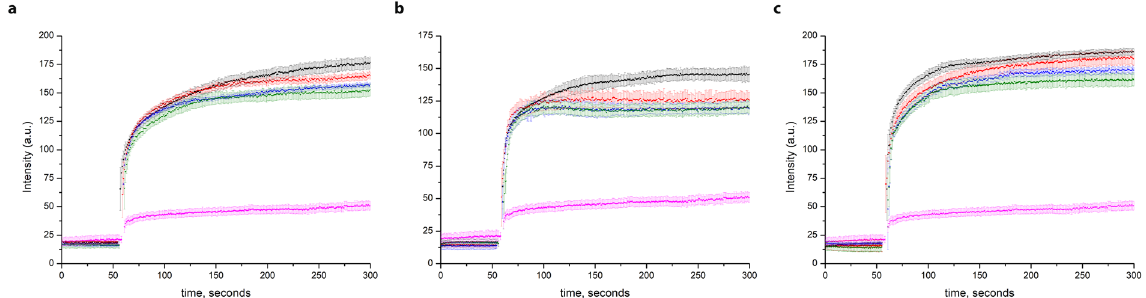
Figure 3. The incapability of hexamminecobalt(III) chloride (CoHex) to inhibit the transport of Zn 2 + by proteoliposomes with ( a ) TmCorA, ( b ) MjCorA and ( c ) ZntB. Black—25 μ M Zn 2 + with no added CoHex, magenta—empty liposomes with 25 μ M Zn 2 + + 50 μ M CoHex. All substrates were simultaneously added at